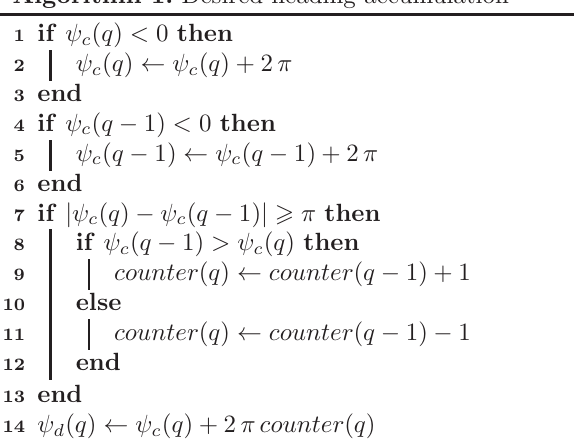
Algorithm 1: Desired heading